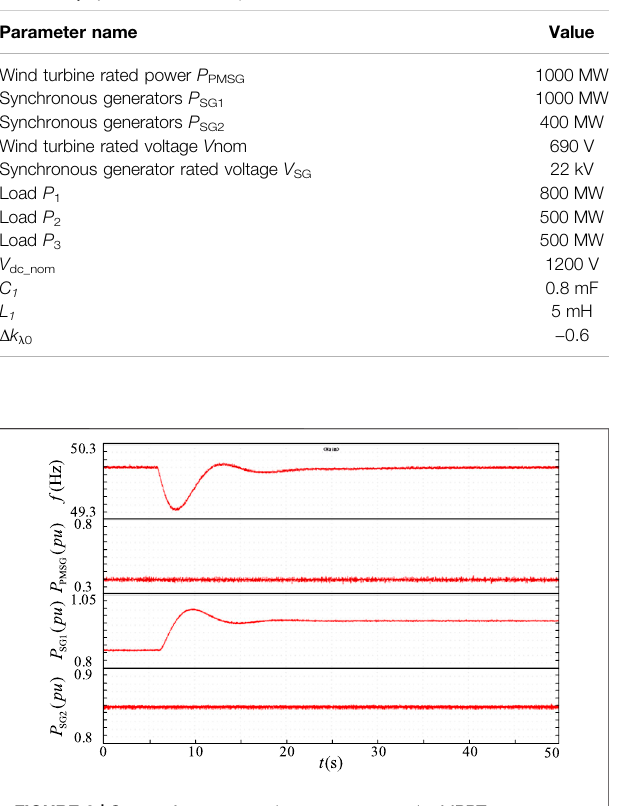
FIGURE 9 | System frequency and output power under MPPT.